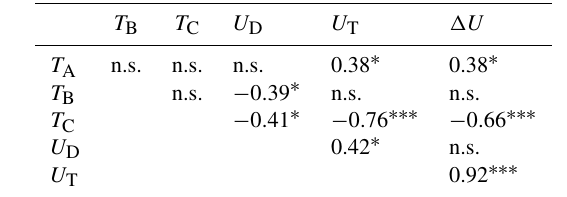
Table 2. Correlations between various combinations of weekly averaged observed parameters with statistical significance indi- cated. These are bottom temperature ( T A ,T B ,T C ) and along-valley components (towards 225 ◦ ) of deep velocity ( U D ) and top ve- locity ( U T ). (cid:49)U is the difference between top and deep velocity ( (cid:49)U = U T − U D ). Only statistically significant correlation coeffi- cients ( p < 0 . 05) are shown. The others are listed as “n.s.”. All pa- rameters have been linearly de-trended before correlation. Introduc- ing lags between the parameters did not give better correlations for any of the cases in the table. ∗ and ∗∗∗ indicate statistical signifi- cance as detailed in Sect. 2.4.